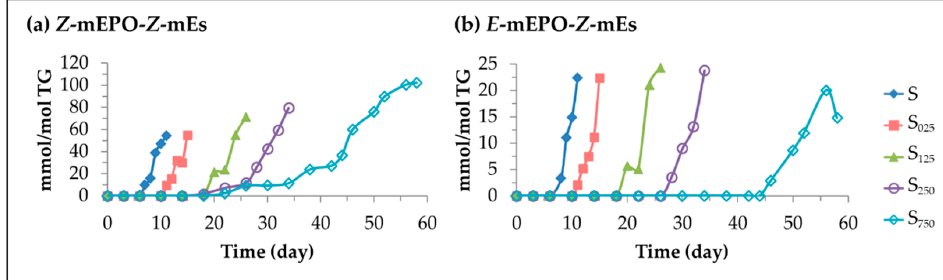
Figure 16. Evolution of the concentration, expressed in mmol/mol TG, in samples S, S 025 , S 125 , S 250 and S 750 throughout the storage at 70 °C up to a very advanced oxidation stage of: ( a ) Z -mEPO- Z -mEs; ( b ) and of E -mEPO- Z -mEs.